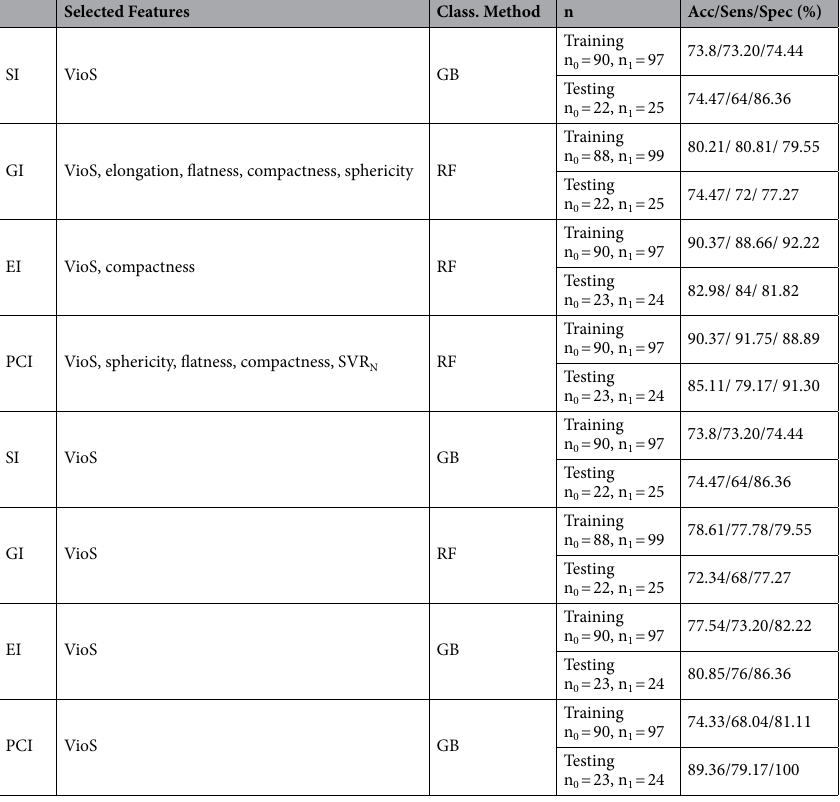
Table 3. Best classification results for each dose plan indices using either the features selected by RFE-SVM or VioS in the training and test